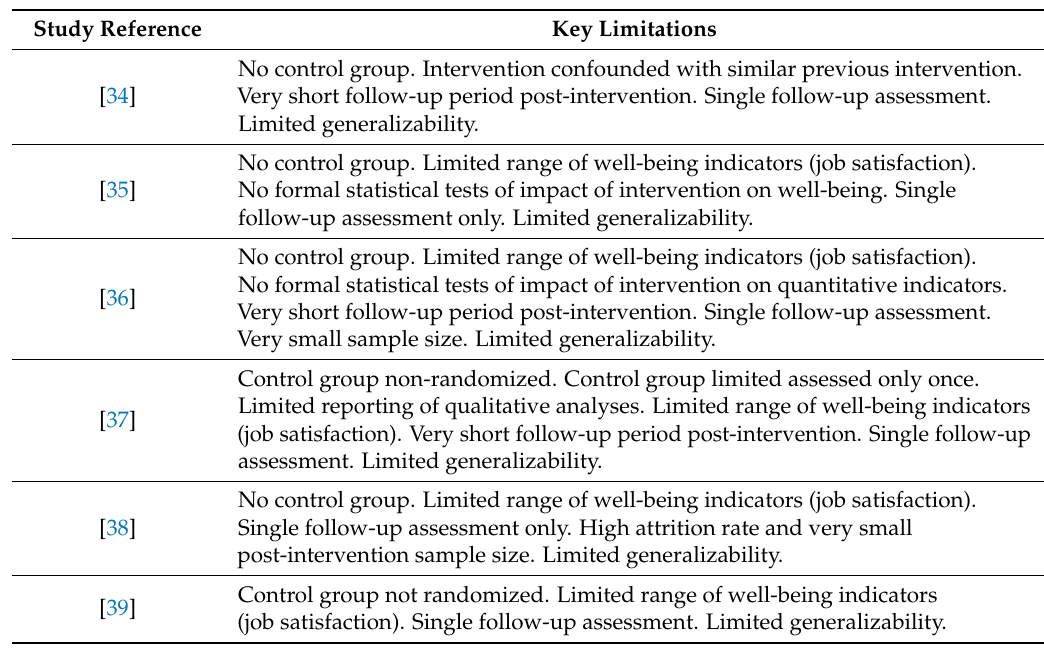
Table 2. Key limitations of studies on shared social